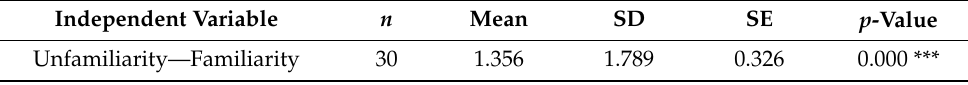
Table 14. Paired t -test results for the product search times (familiarity vs. unfamiliarity).